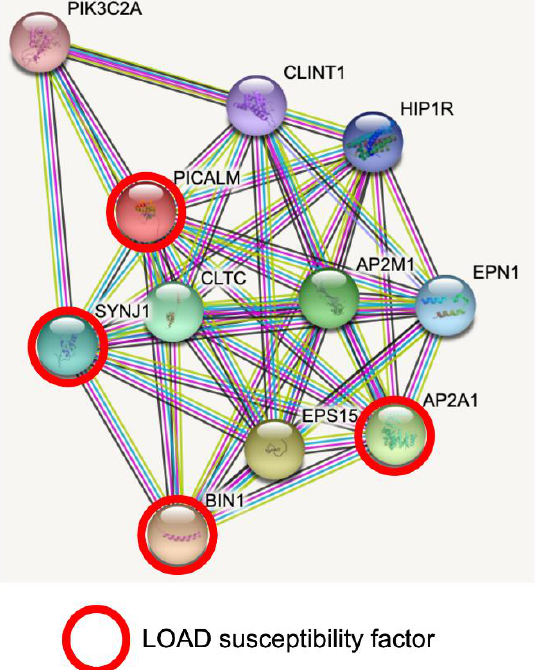
Figure 1. PICALM interacts directly with several GWAS hits identified in LOAD. Predicted protein– protein interactions by STRING database analysis (https://string-db.org (accessed on 1 June 2022)) show several key proteins for clathrin-mediated endocytosis and intracellular trafficking as PICALM interactors [40]. AP2A1 and BIN1 have been identified as GWAS hits [41]. SNPs of SYNJ1 have significant associations with disease onset of AD [45]. CLTC: Clathrin heavy chain 1. SYNJ1: Synaptojanin1. PIK3C2A: Phosphatidylinositol 4-phosphate 3-kinase C2 domain-containing subunit α . CLINT1: Clathrin interactor 1. HIP1R: Huntingtin-interacting protein 1-related protein. AP2M1: AP2 complex subunit mu. EPN1: Epsin-1. AP2A1: AP2 complex subunit α -1. EPS15: Epidermal growth factor receptor substrate 15. BIN1: Myc box-dependent-interacting protein